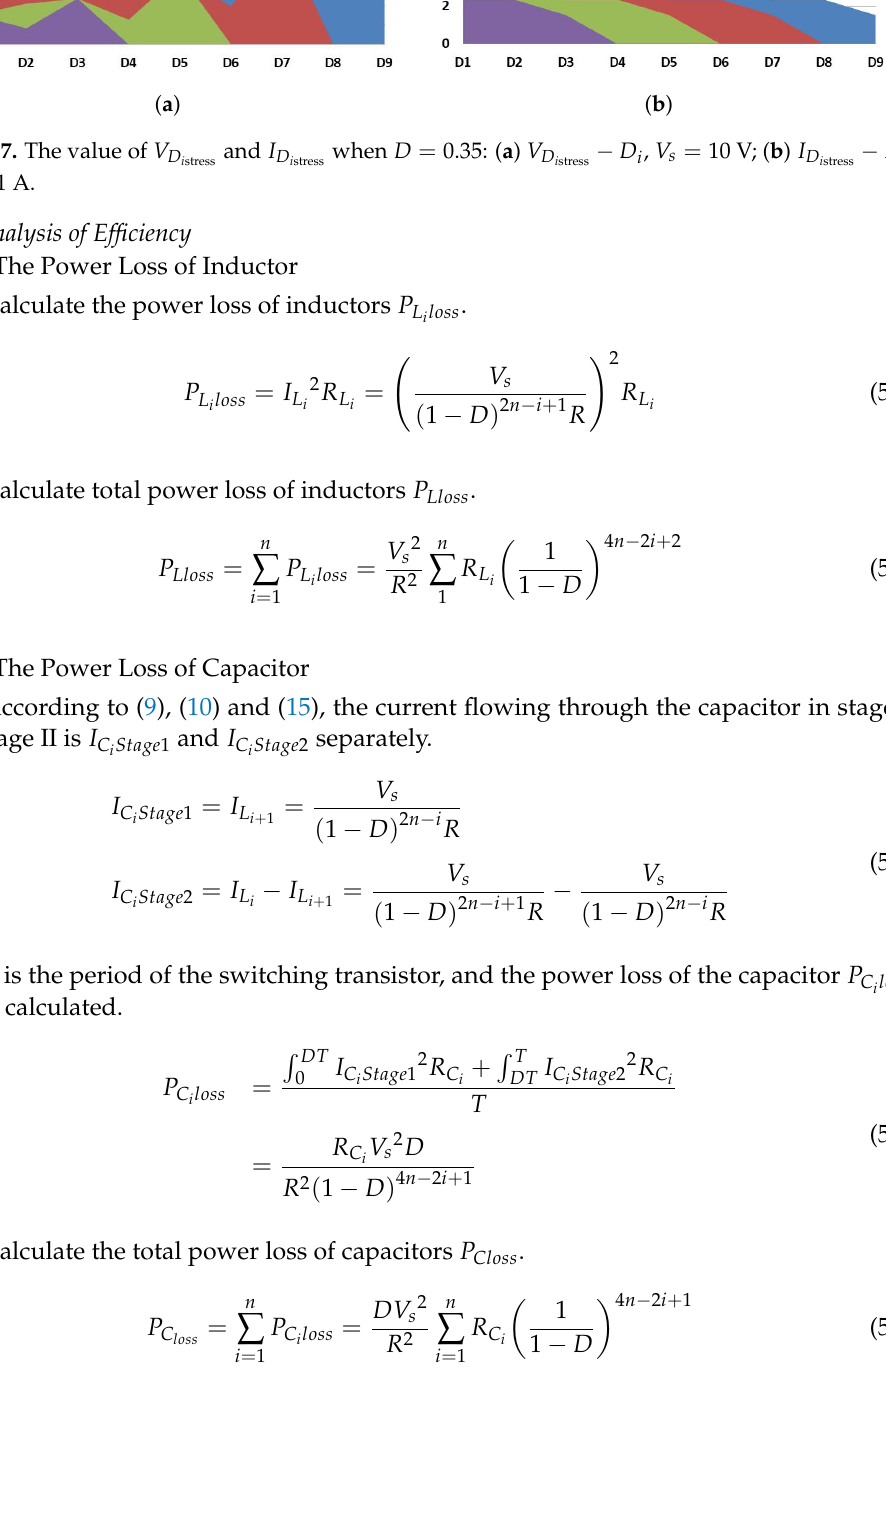
− D = 10 V; ( b ) I i , V s i stress